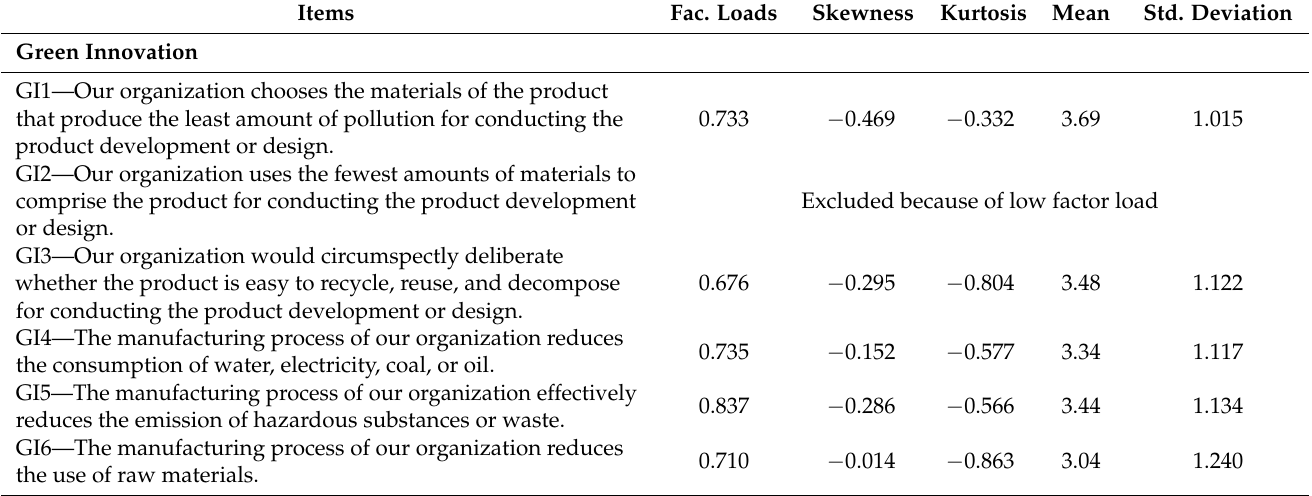
Table 2. Results of exploratory factor